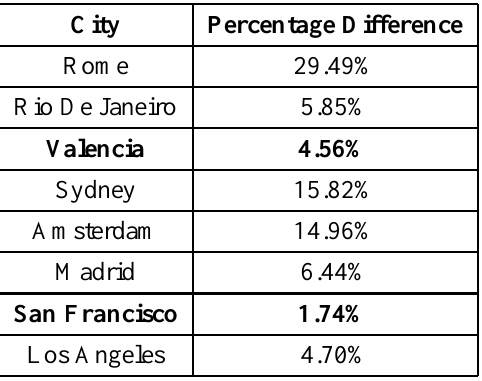
Table 3. Average percentage difference with respect to the mean